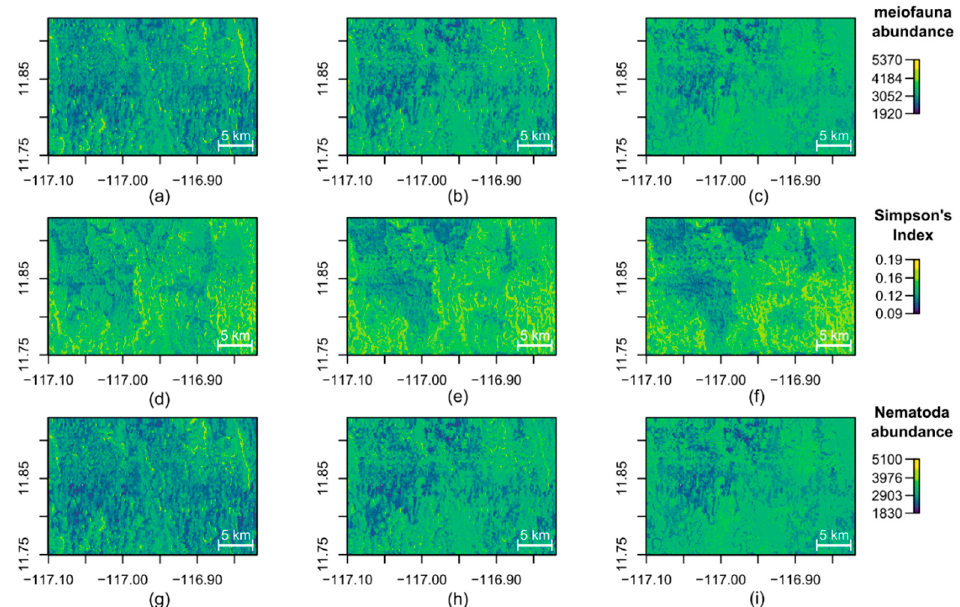
Table 4. Pairwise Pearson’s correlation of the spatial predictions based on random forest regres- sion computed for overall meiofauna abundance, Simpson’s diversity index and abundance of the taxon Nematoda using backscatter and bathymetry only (a), sediment and nodule parameters only (b) or all available predictors (c) as predictor variables. All correlations are highly significant. Variable